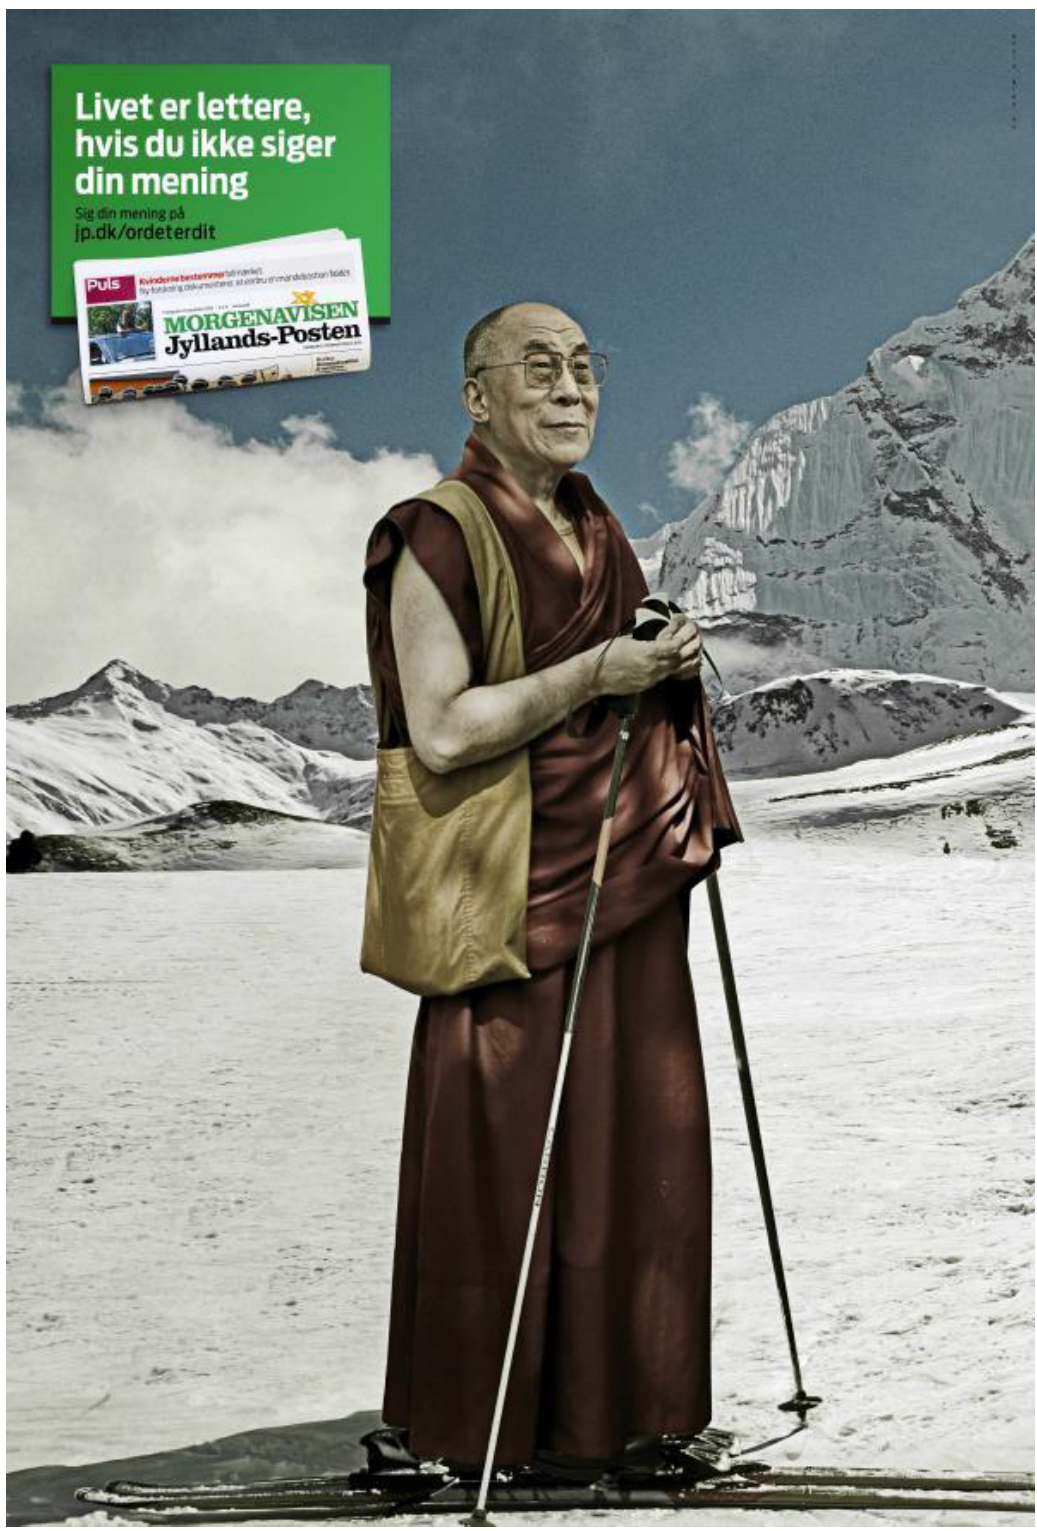
Figure 2: Dalai Lama branding newspaper. ©Jyllands Posten. Reproduced with